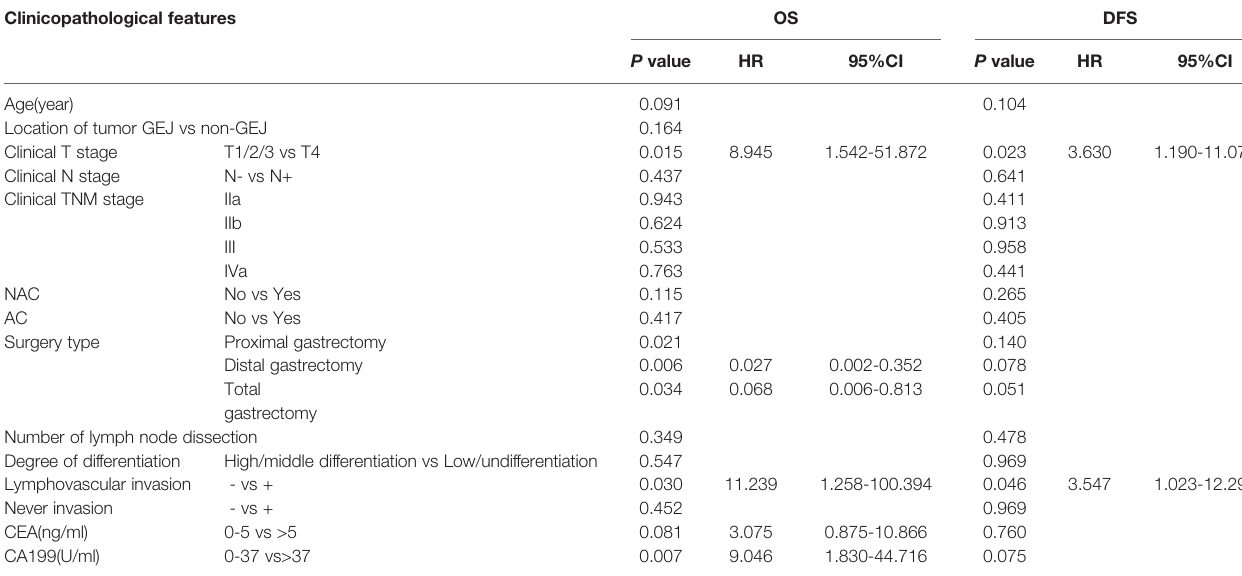
TABLE 3 | Multivariate analysis of overall survival (OS) and disease-free survival time (DFS) before propensity score matching analysis. Clinicopathological